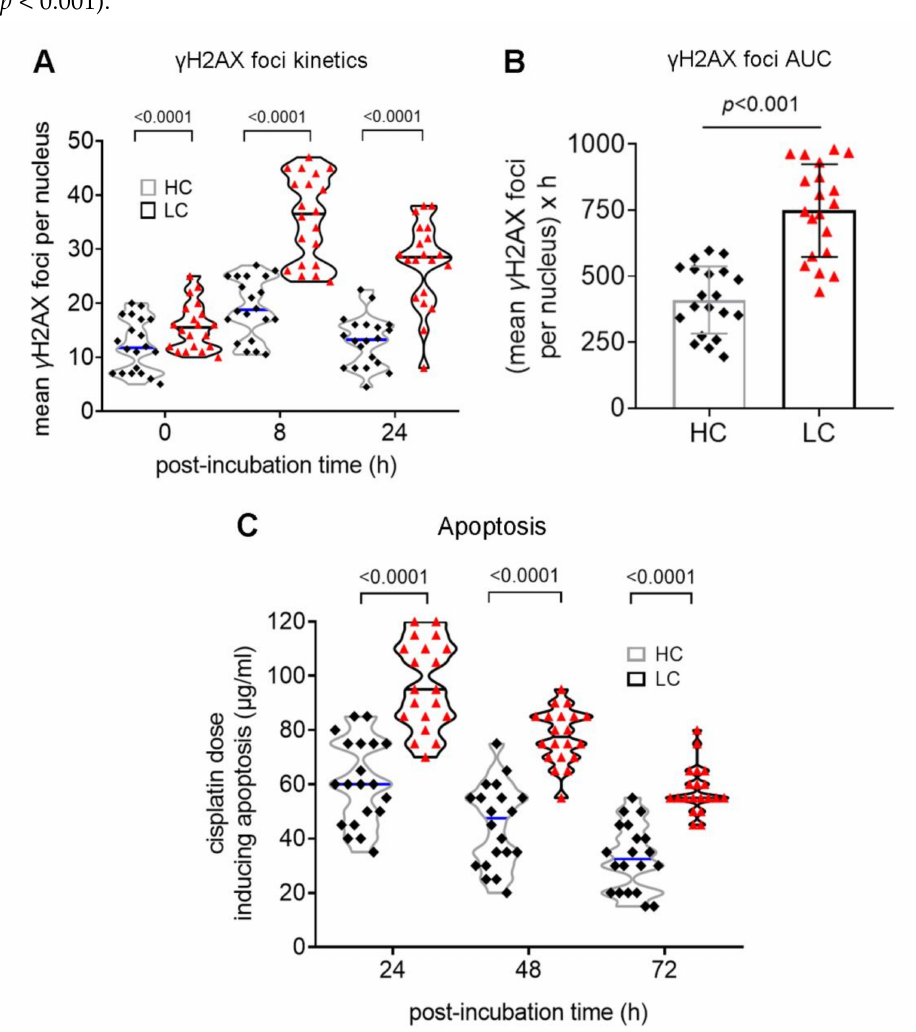
Figure 4. Impaired DSB repair and apoptosis rates in lung cancer patients. ( A ) The kinetics of cisplatin-induced γ H2AX foci and ( B ) the statistical distribution of the γ H2AX foci accumulation, expressed as AUC. ( C ) Box plots showing statistical distribution of the lowest concentrations of cisplatin required for the induction of apoptosis 24 h, 48 h and 72 h after treatment with various doses of cisplatin. HC, healthy control, black square; LC, lung cancer, red triangle. The experiments shown were based on a minimum of 3 independent